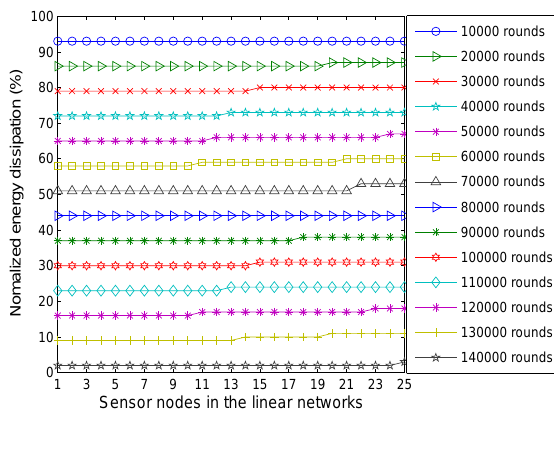
Figure 14. Energy dissipation vs sensor